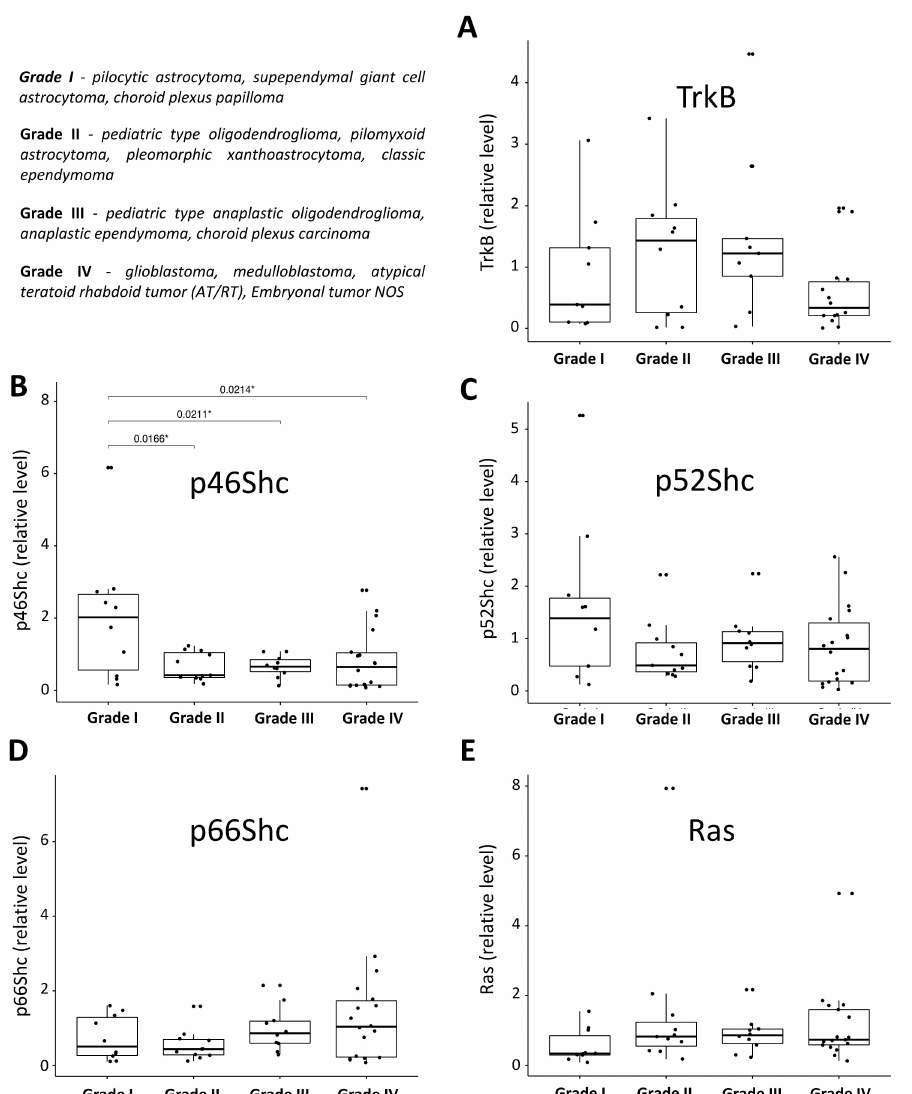
Figure 9. Box plot graphs showing the TrkB, Ras, and ShcA isoforms’ western blot quantification in the investigated pediatric brain tumors divided by the grade of malignancy. The presented box plots show the standardized levels of TrkB ( A ), p66Shc ( D ), p52Shc ( C ), p46Shc ( B ), and Ras ( E ) proteins in the four groups of tumor samples divided based on the WHO grade, representing the severity and prognosis of the condition. The assignment of the grade to the tumor type is shown in the top left corner. The position of each dot on the vertical axis indicates values for an individual data point. * p < 0.05. The level of TrkB, p66Shc, p52Shc, p46Shc, and Ras was assessed by the western